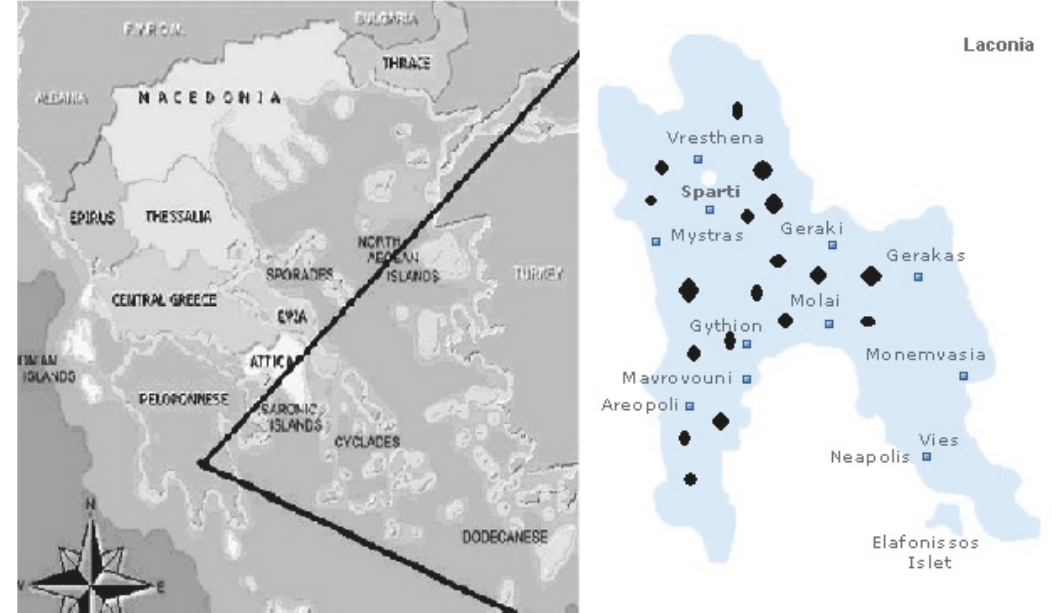
Figure 1: Map of Laconia and sampling sites. Black dots represent the various sites of cluster sampling of high-risk populations and the white dot represents the city of Sparta where the students (low-risk population) attend the